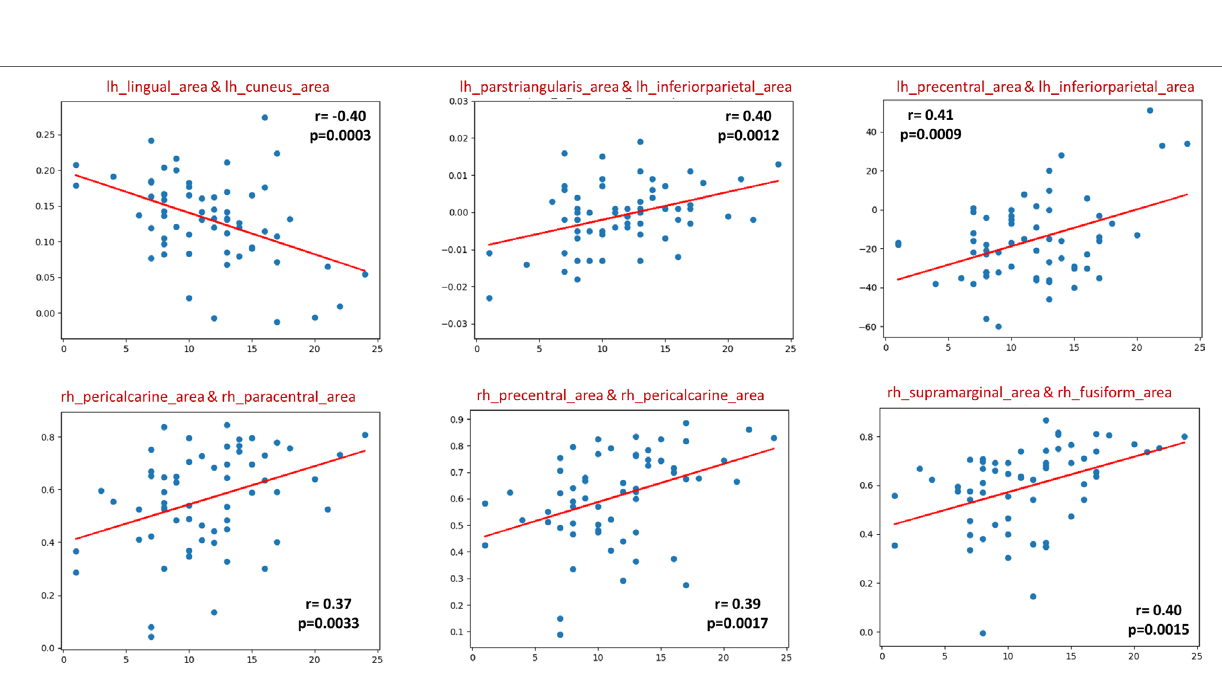
thickness: 12 times, mean curvature: 25 times, Gaussian curvature: 16 times, foldness index: 82 times, curvature index: 29 times, and SA: 75 times. Figure 7 shows sample of correlation of both sMRI and fMRI with ADOS overall score. Also, Figures 8 and 9 show the most frequent areas associated with features having significantly correlated features with overall ADOS score.